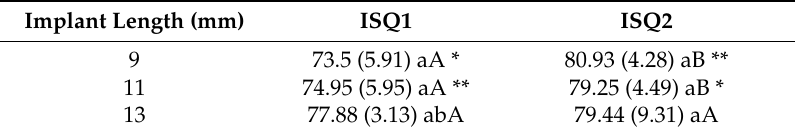
Table 3. Tukey’s multiple comparison test of ISQ1 and ISQ2 values for 9-, 11- and 13-mm implants. Numbers are means and values in brackets are standard deviations. Lowercase letters indicate statistically significant differences among the length within the ISQ 1 or 2 values. Uppercase letters indicate statistically significant differences between the ISQ 1 or 2 values within the length. * and ** indicate statistically significant differences between ISQ1 and 2 values across the lengths.